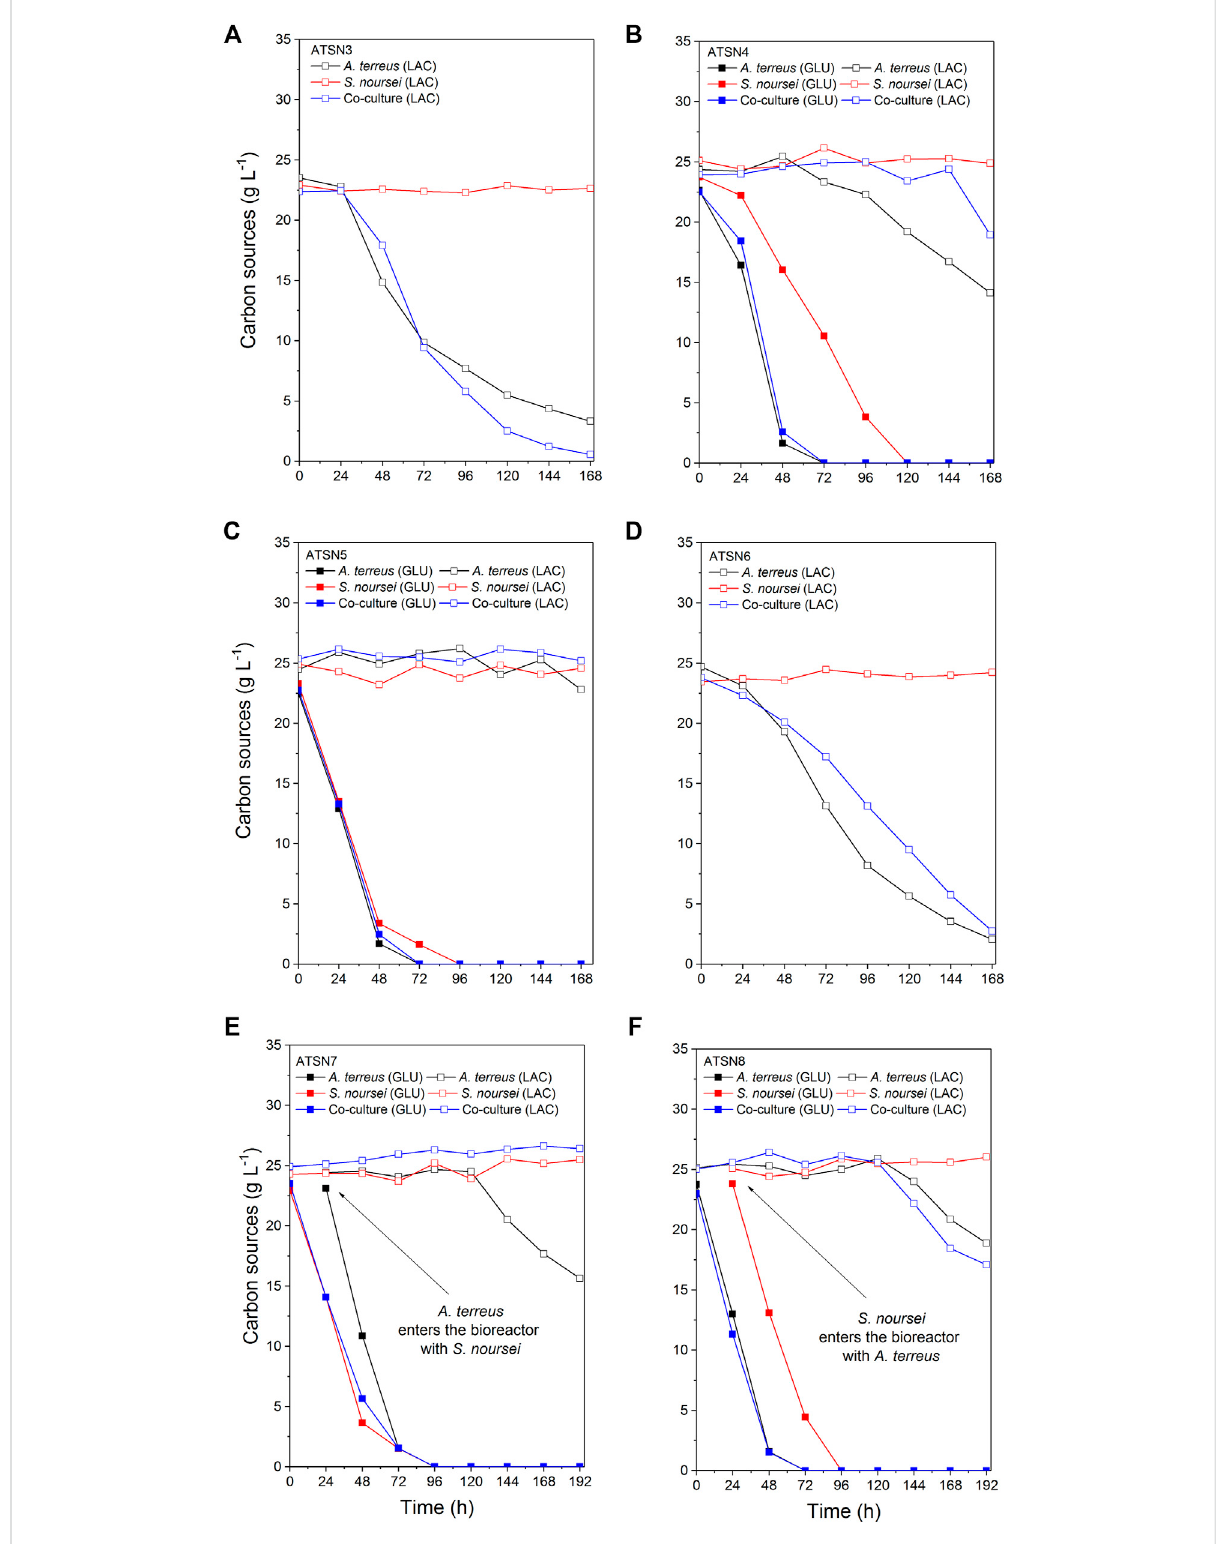
FIGURE 6 TemporalchangesofglucoseandlactoseconcentrationinA. terreus andS. noursei co-culturesandthecorrespondingmonoculturesinthe (A) ATSN3, (B) ATSN4, (C) ATSN5, (D) ATSN6, (E) ATSN7, and (F) ATSN8